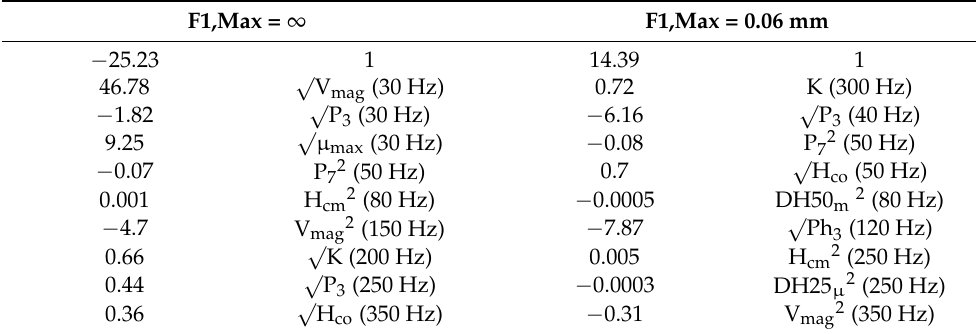
Table 9. Overview of the regression results for carburization depth (calibration data